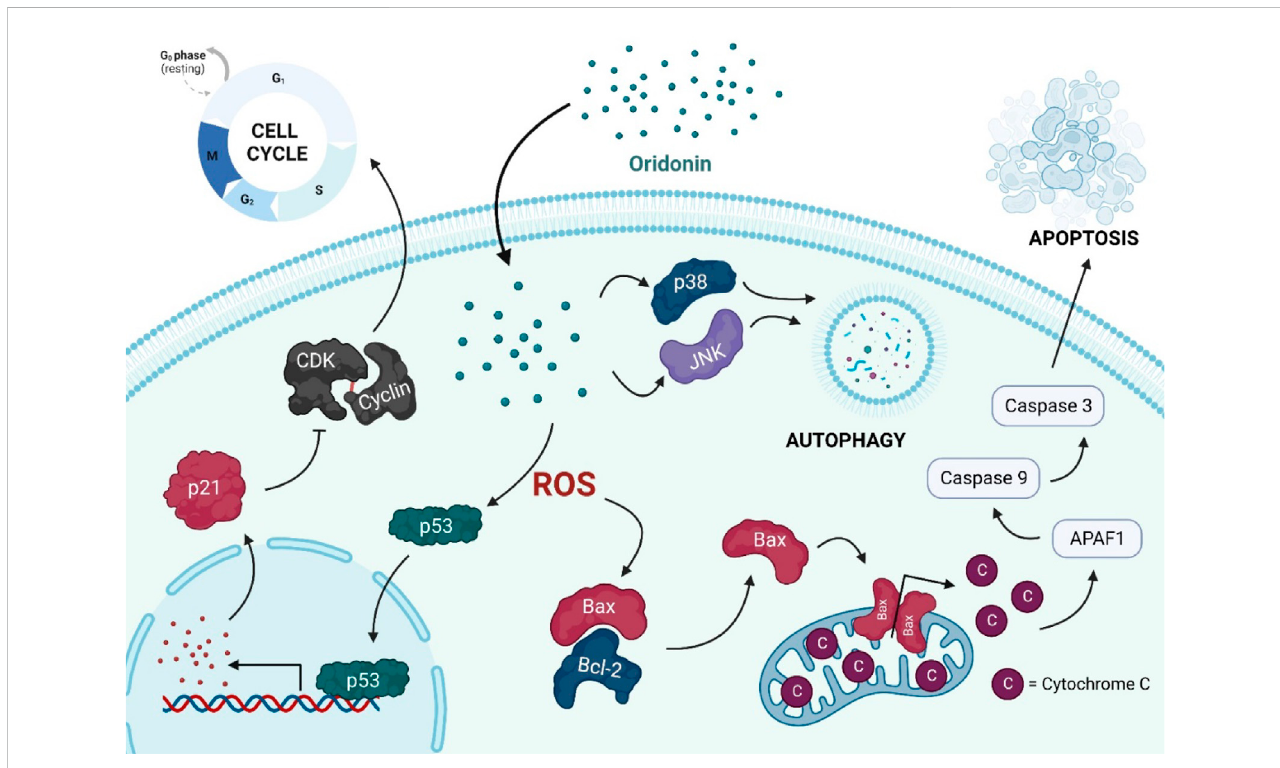
FIGURE 1 Schematic representation of the relevant signaling pathways modulated by